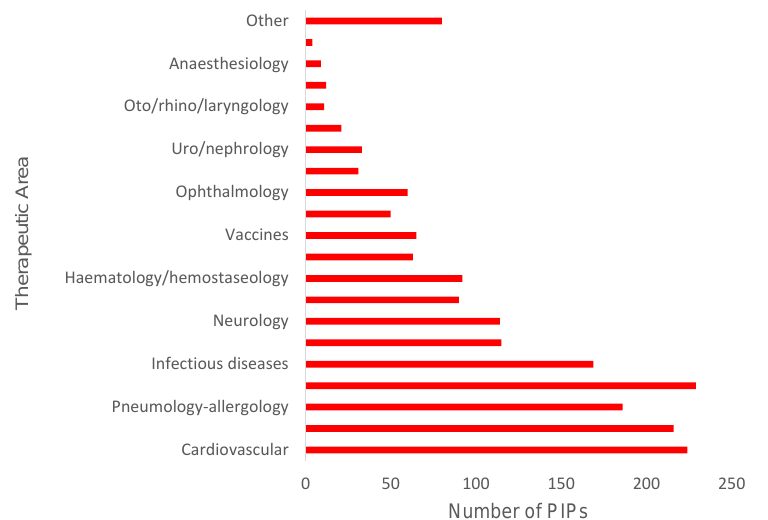
Figure 4. Total number of PIPs (all decision types combined) granted by the PDCO since establishment of the EUPR in 2007, subdivided by EMA therapeutic areas. Data taken from EMA repository [20]. See methods for details on data mining. PIP: paediatric investigation plan; PDCO: Paediatric Committee; EUPR: European Union Paediatric Regulation.